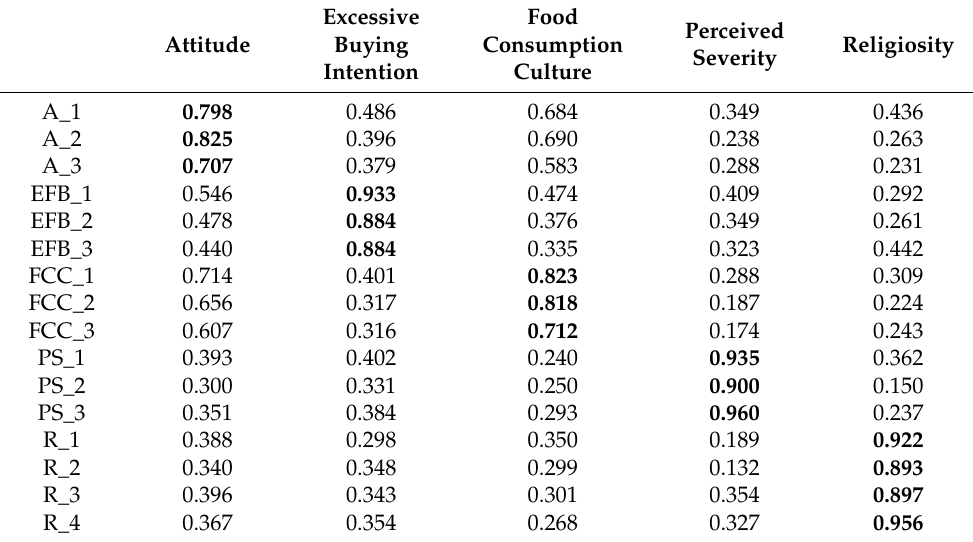
Table 2. The outer-loading and cross-loadings.